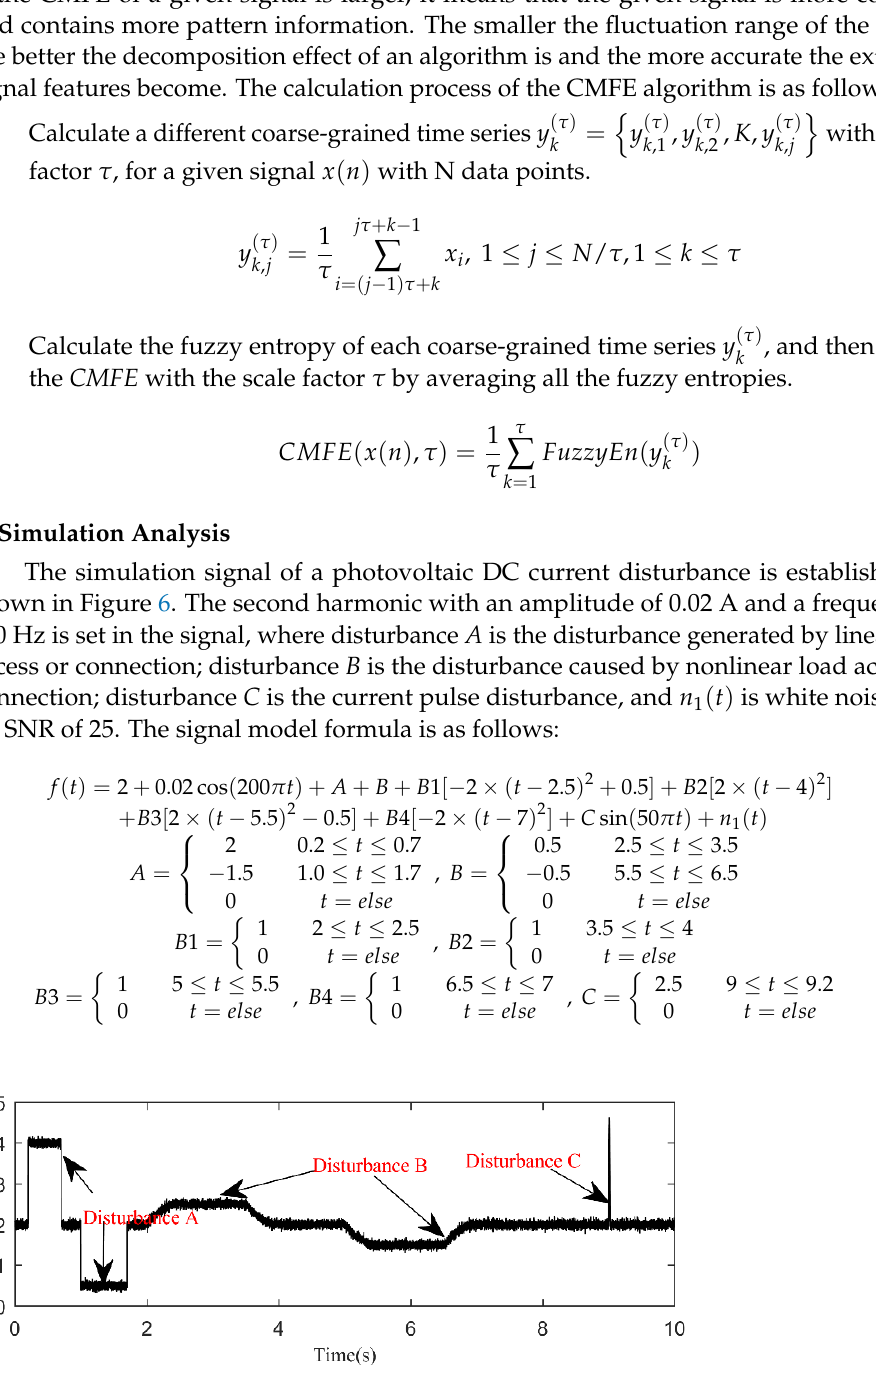
Figure 6. Photovoltaic DC simulation signal diagram.